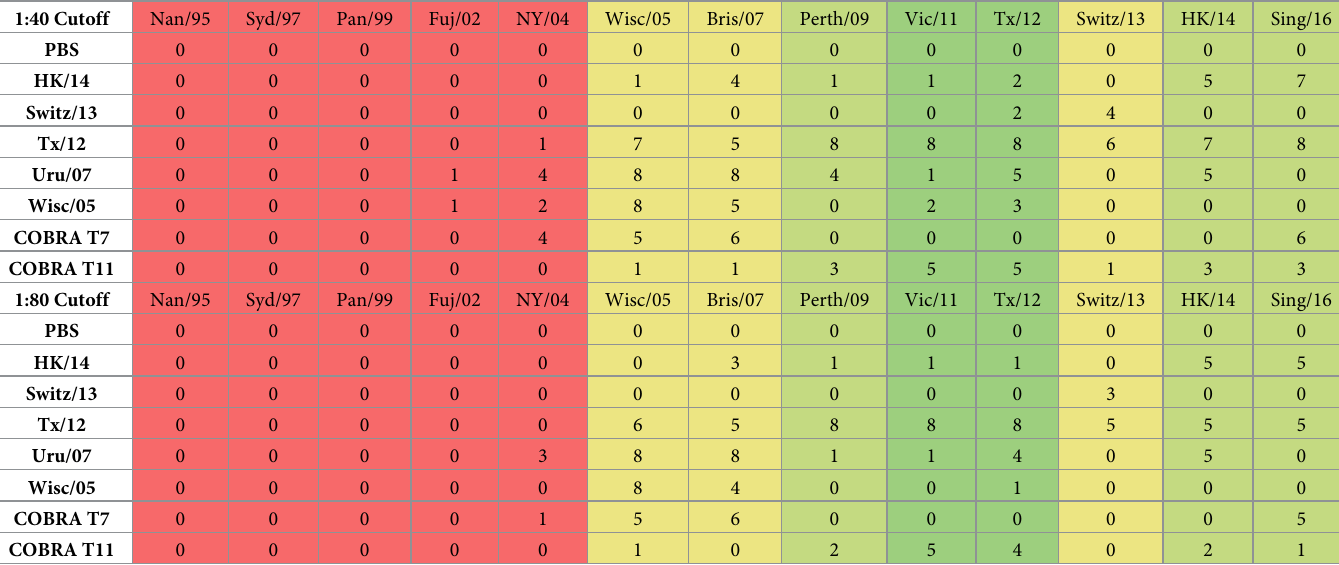
Table 2. Historical vaccine strain panel (1995–2016) HAI heat map.